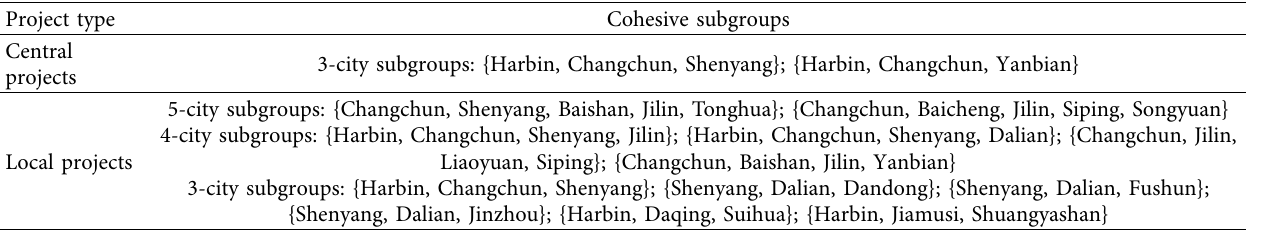
Table 6: Cohesive subgroups in regional networks.